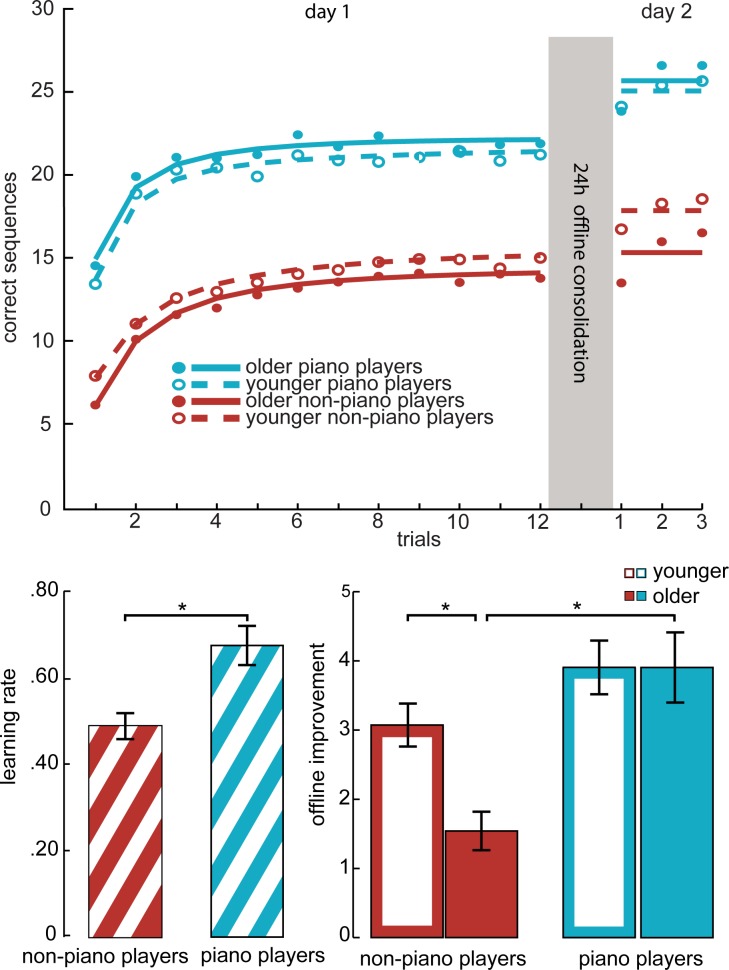
Top: Performance in the finger-tapping motor task, split for younger and older piano players and non-piano players. Performance is given by the amount of correctly tapped sequences for each 30s trial. The points indicate the averaged group data, while the curves depict the averaged fitted model for the learning session on day one. For the test session on day two, the line depicts the session mean. Bottom left: Difference in learning rate. For illustration purpose 1-R is depicted, the closer to 1 the value is, the faster the participants achieved their plateau performance. Bottom right: Memory improvement from the last three trials of day one to the three trials on day 2. The error bars denote the standard error of the mean; the asterisk denotes a significant difference (p < .05).